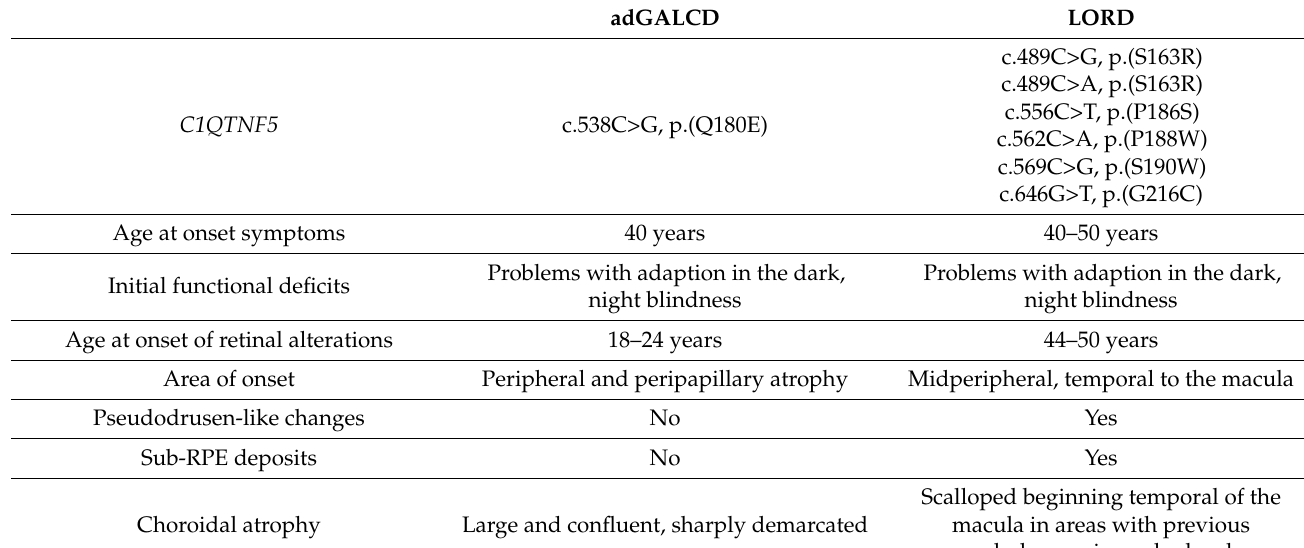
Table 4. Phenotypes of C1QTNF5 associated disorders: adGALCD and LORD.